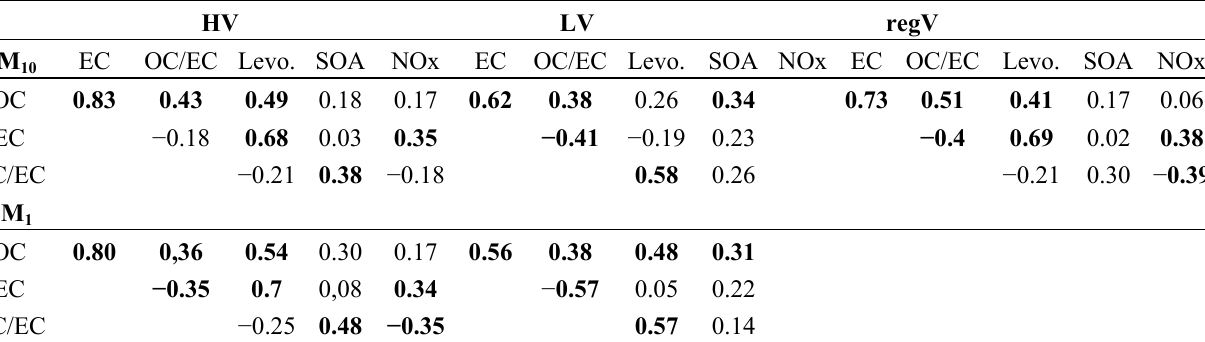
Table 2. Correlations after Pearson between OC, EC, OC/EC, levoglucosan, NOx and